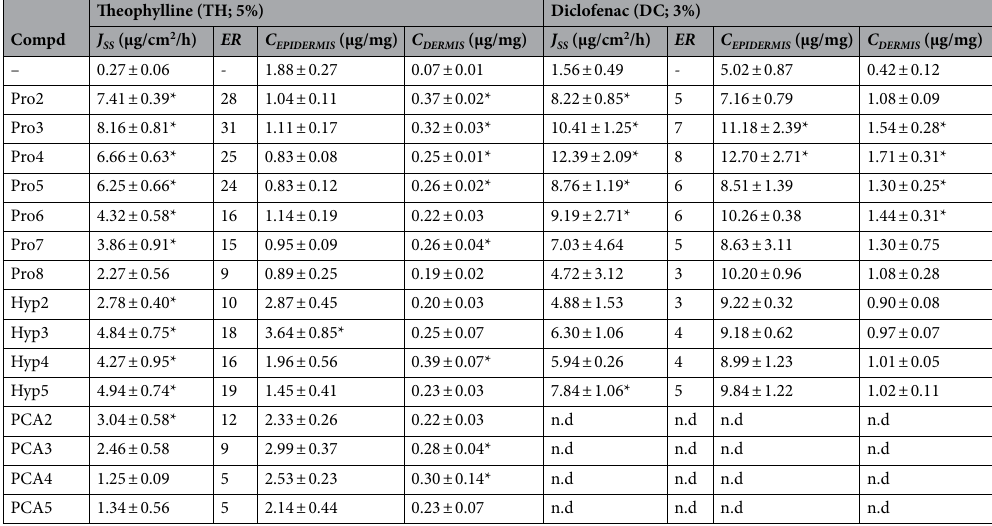
Table 1. Effects of Pro, Hyp, and PCA derivatives on the flux and skin retention of model drugs theophylline and diclofenac. J SS , steady-state flux; ER, enhancement ratio; C EPIDERMIS and C DERMIS , drug concentration in epidermis and dermis, respectively. Enhancers (1%) were co-applied with the respective drug (infinite dose) in 60% PG. Controls were samples without enhancers. Data are presented as means ± SEM; n ≥ 3. * significant compared to the control (without enhancer) at p <